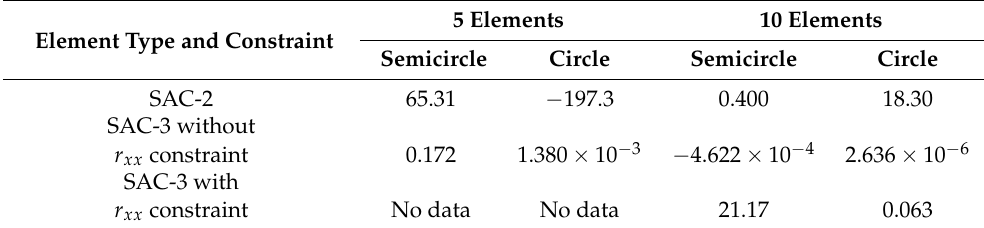
Table 3. The horizontal error of ending point with